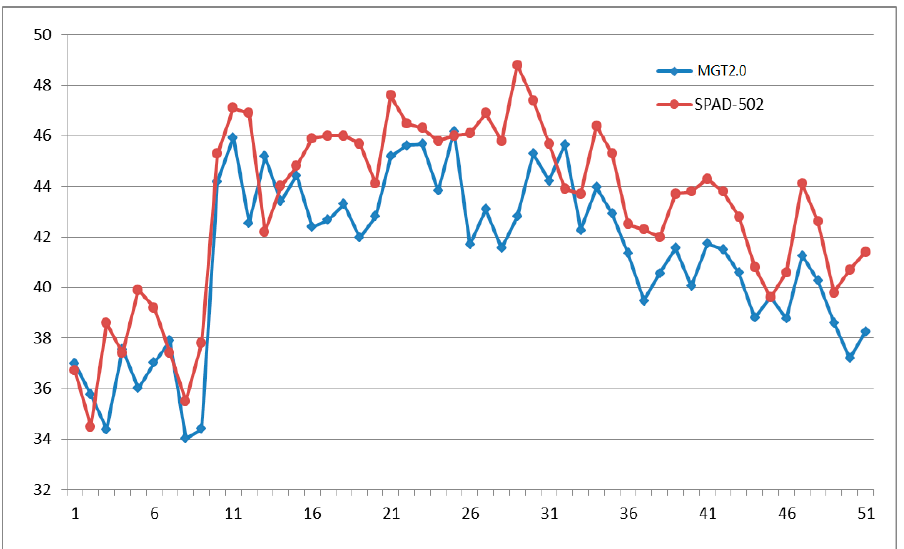
Figure 14. Fifty chlorophyll relative content (SPAD) experimental results by MGT2.0 (marked by blue line) and SPAD-502 (marked by red line).